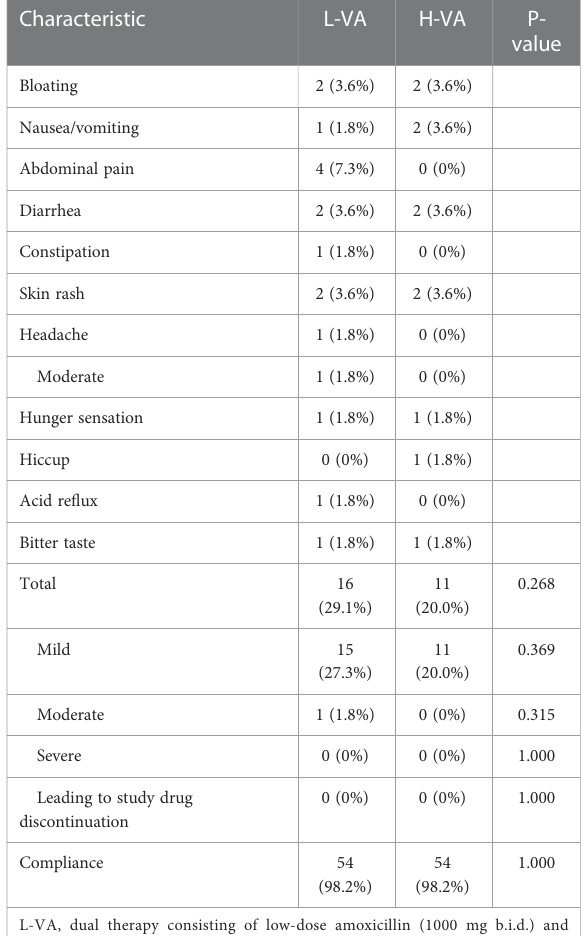
TABLE 3 Treatment-emergent adverse events and patient compliance of each treatment group (n, %). Characteristic